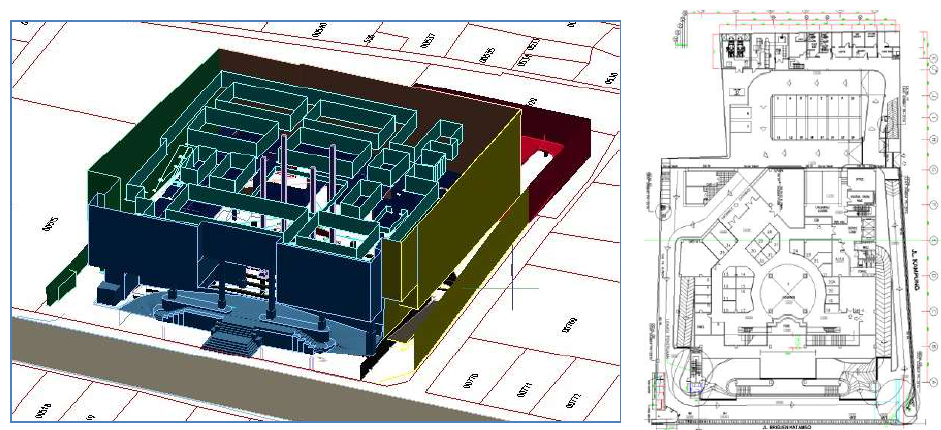
Figure 5. The results of a field survey of object 3, an electronic mall, are drawn in the CAD format (left) along with its one of floor plans (right).